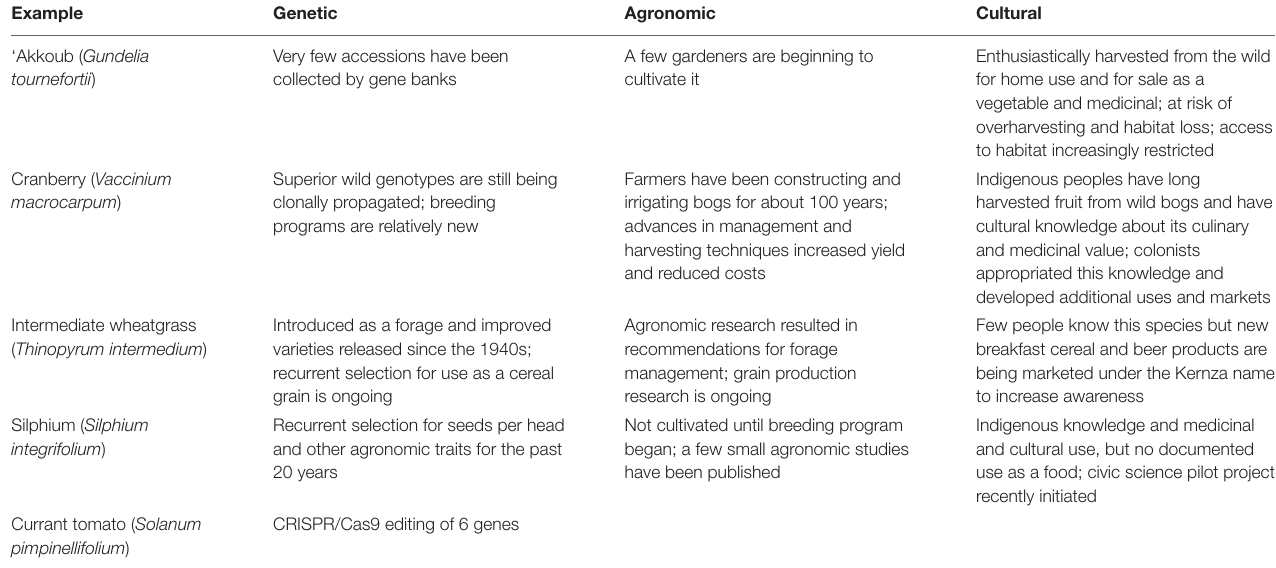
TABLE 3 | Summary of examples of genetic, agronomic, and cultural change for plant domestication projects discussed in this article. Example Genetic Agronomic